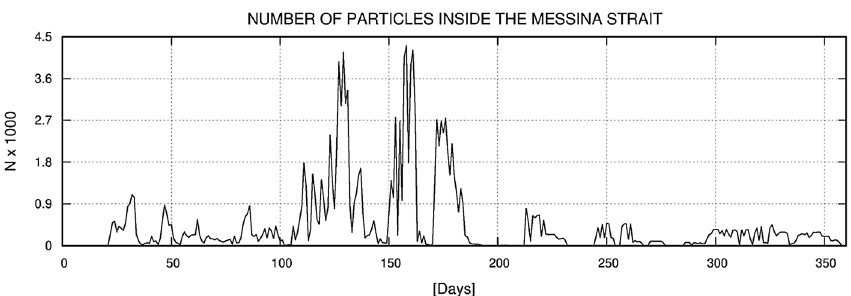
Figure 13. Daily amount of numerical particles inside the Strait throughout the year. A total of 20,000 particles were released every 24 h in the selected spawning areas around the Aeolian Island Archipelago.